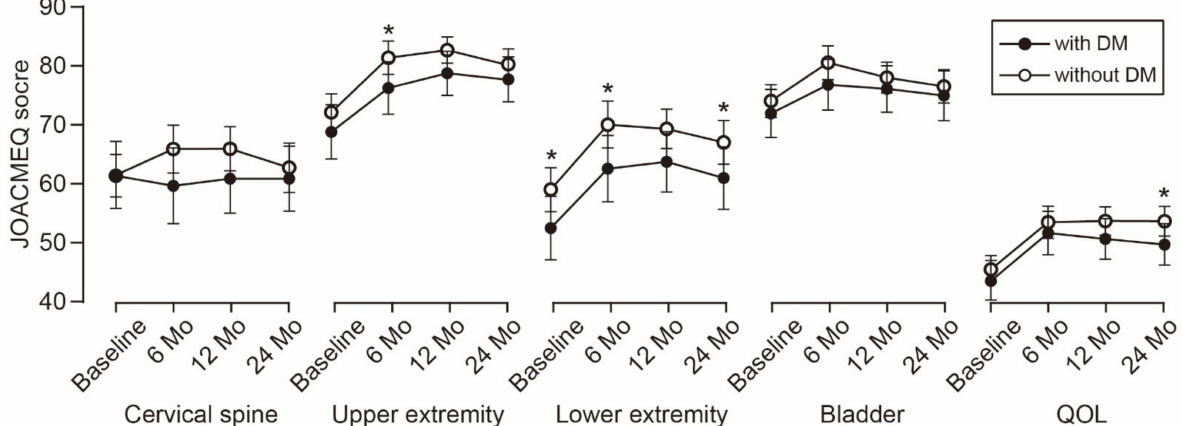
Figure 2. Time-dependent change in JOACMEQ scores. The difference in lower extremity function was significant during the observation period, except for the 1-year follow-up. The difference in upper extremity function showed statistical significance at the 6-month follow-up. The difference in the QOL domain between the groups increased over time and reached statistical significance at the 2-year follow-up. * p < 0.05, unpaired t -test. JOACMEQ, Japanese Orthopedic Association Cervical Myelopathy Evaluation Questionnaire; DM, diabetes mellitus; QOL, quality of life.